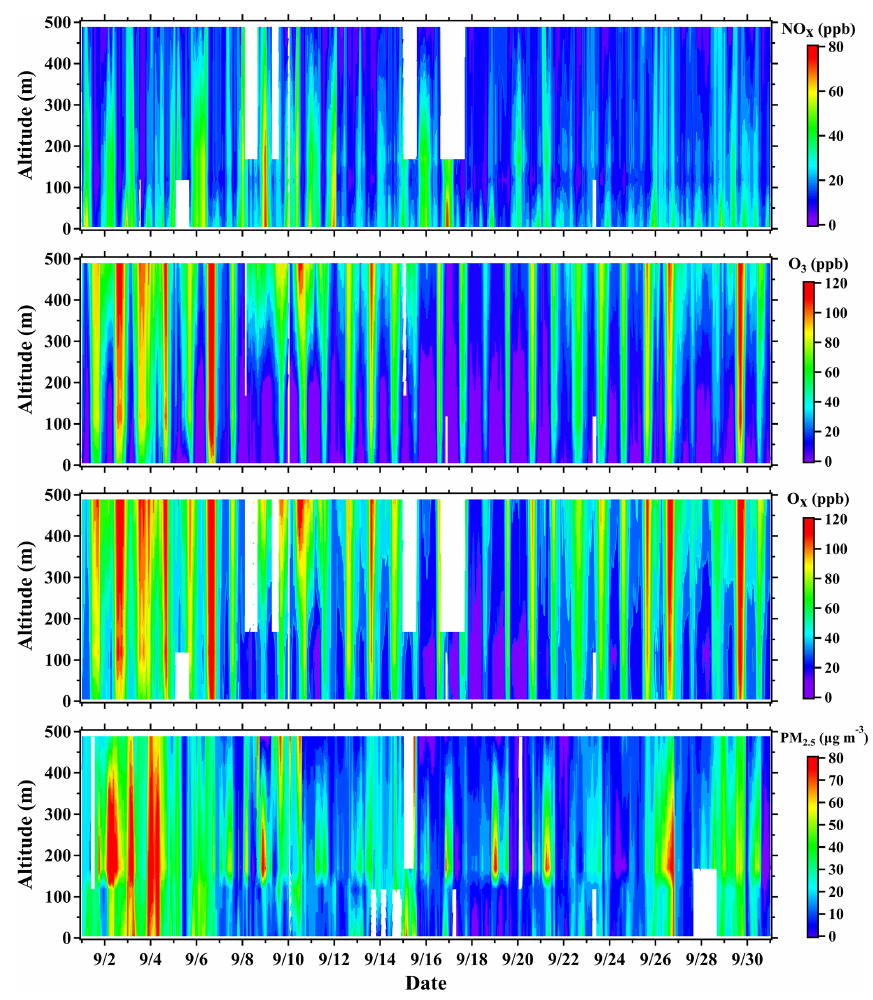
Figure 9. Time series of vertical profiles for O 3 , NO x , O x (O 3 + NO 2 ), and PM 2 . 5 concentrations in September during the CTT campaign. The contour plots are made using the measurements from the four CTT sites (5, 118, 168, and